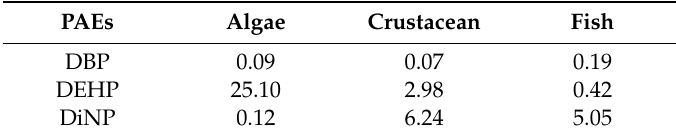
Table 3. Risk quotient (RQ) values of 3 PAEs to sensitive aquatic species.